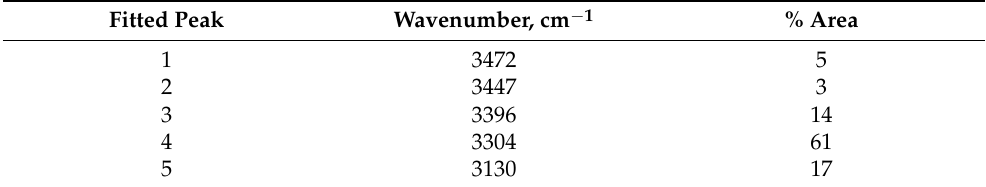
Table 2. Wavenumber and % area of the five fitted peaks presented in Figure